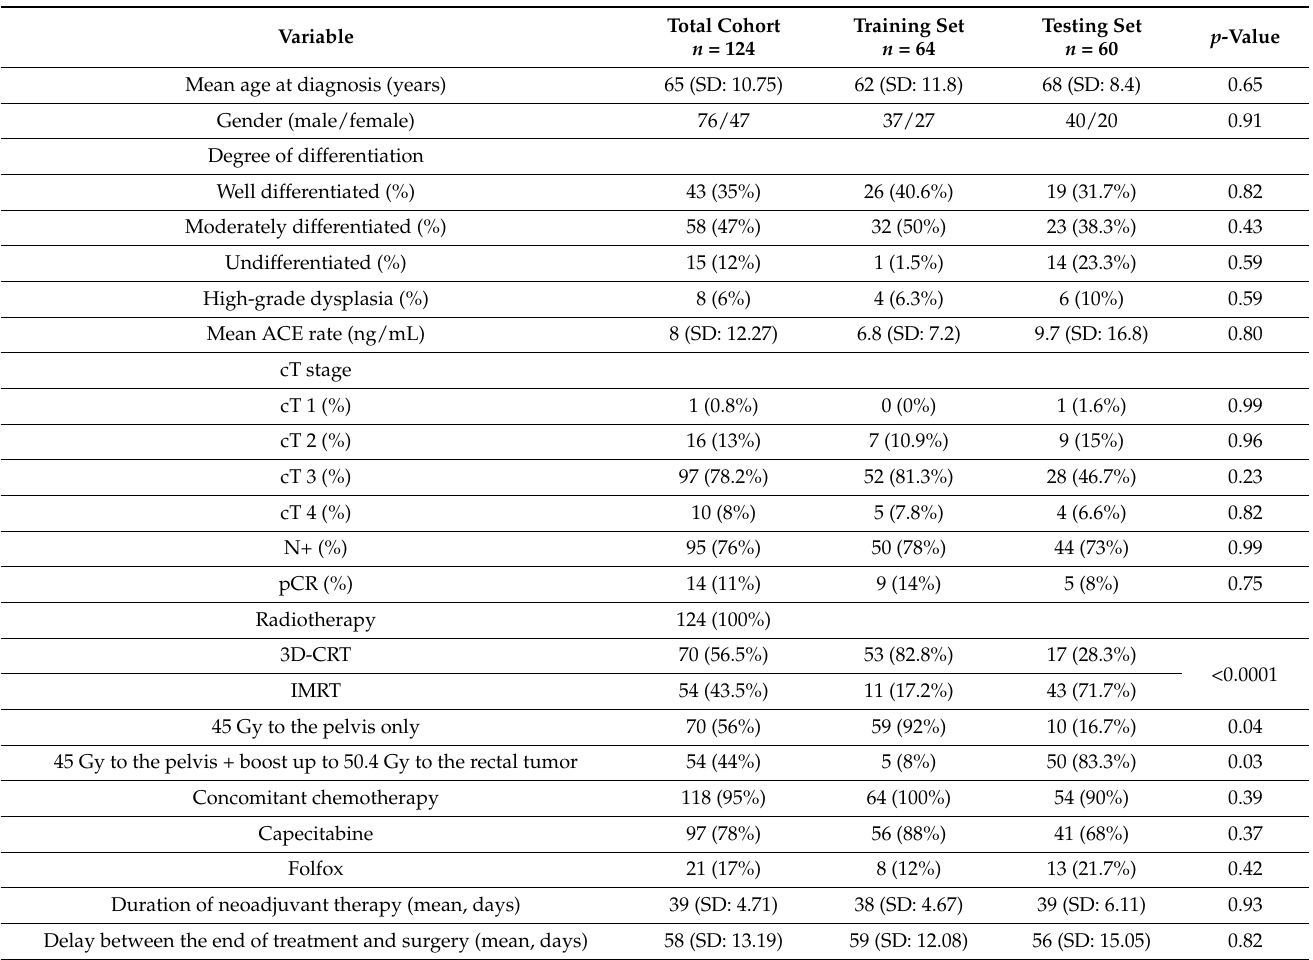
Table 1. Initial characteristics.